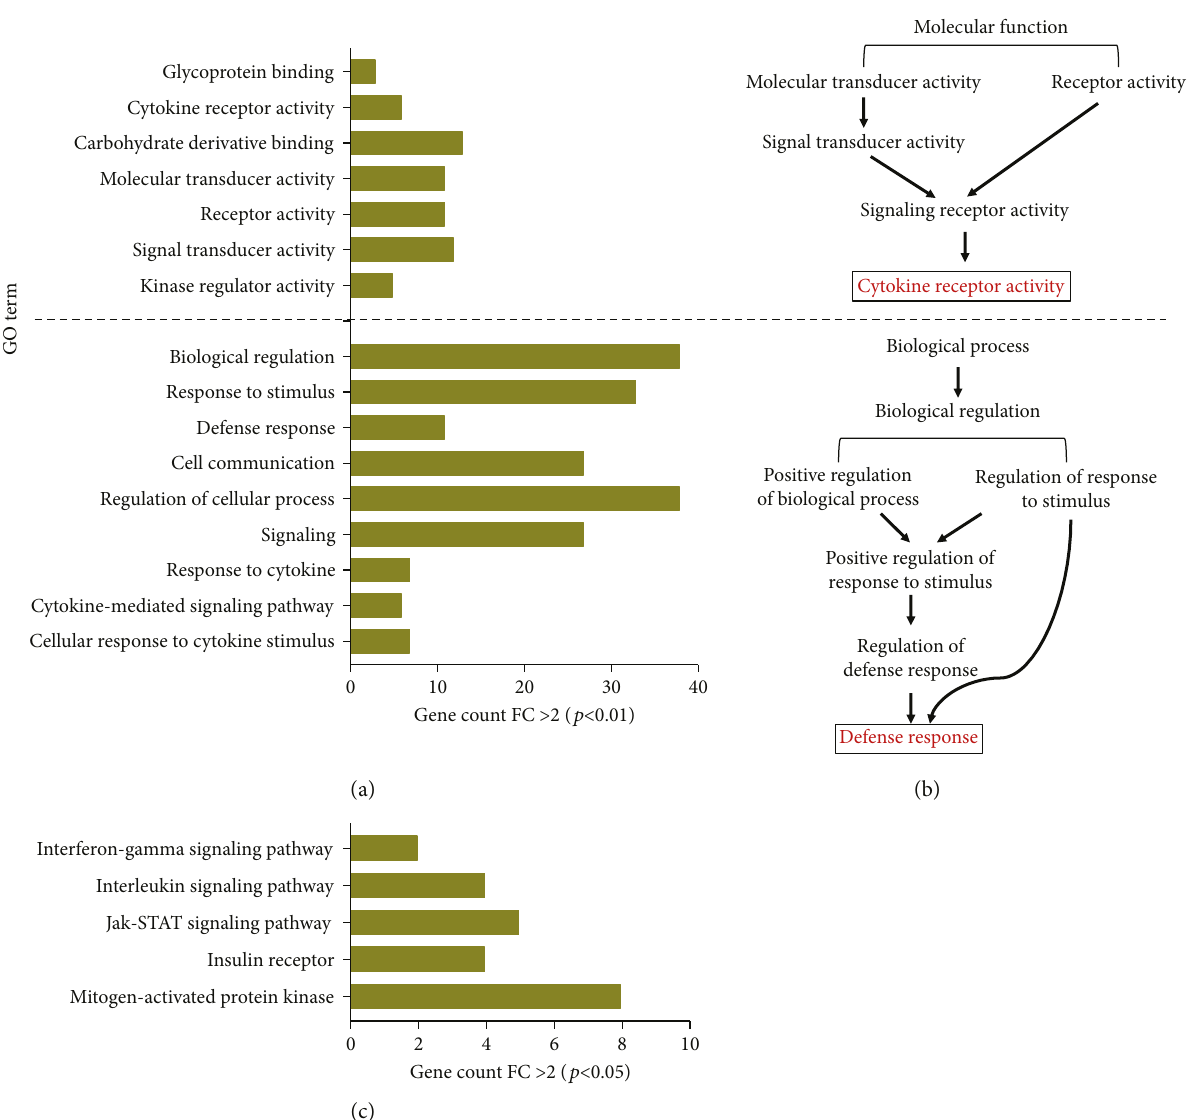
Figure 2: GO enrichment analyses of signi fi cantly di ff erentially expressed genes of neutrophils in response to iRBCs. (a) Gene sets were categorized according to molecular function (upper panel) and biological processes (lower panel). (b) Network-based gene enrichment of the most signi fi cantly enriched terms for molecular function and biological processes. The annotation modules based on STRING for GO terms and multiple testing correction methods ( p < 0 05 ) were performed based on NET-GE tools. (c) Biological pathways enriched in upregulated genes involved in the neutrophil response to